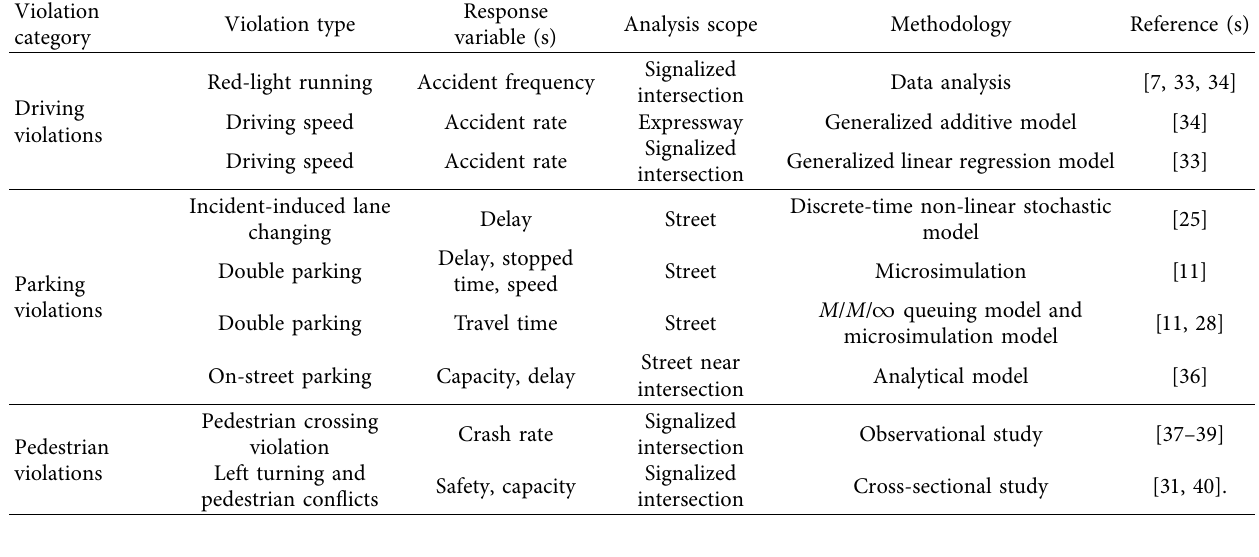
Table 1: Previous studies on trafc violations.